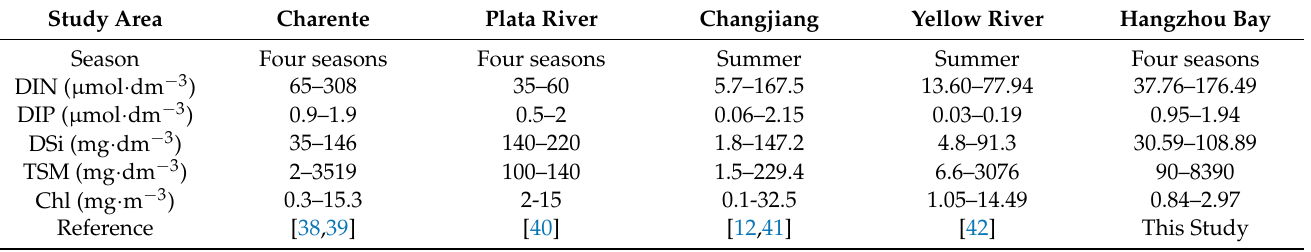
Table 2. Main characteristics (abiotic environment and Chl) of some turbid estuaries including the